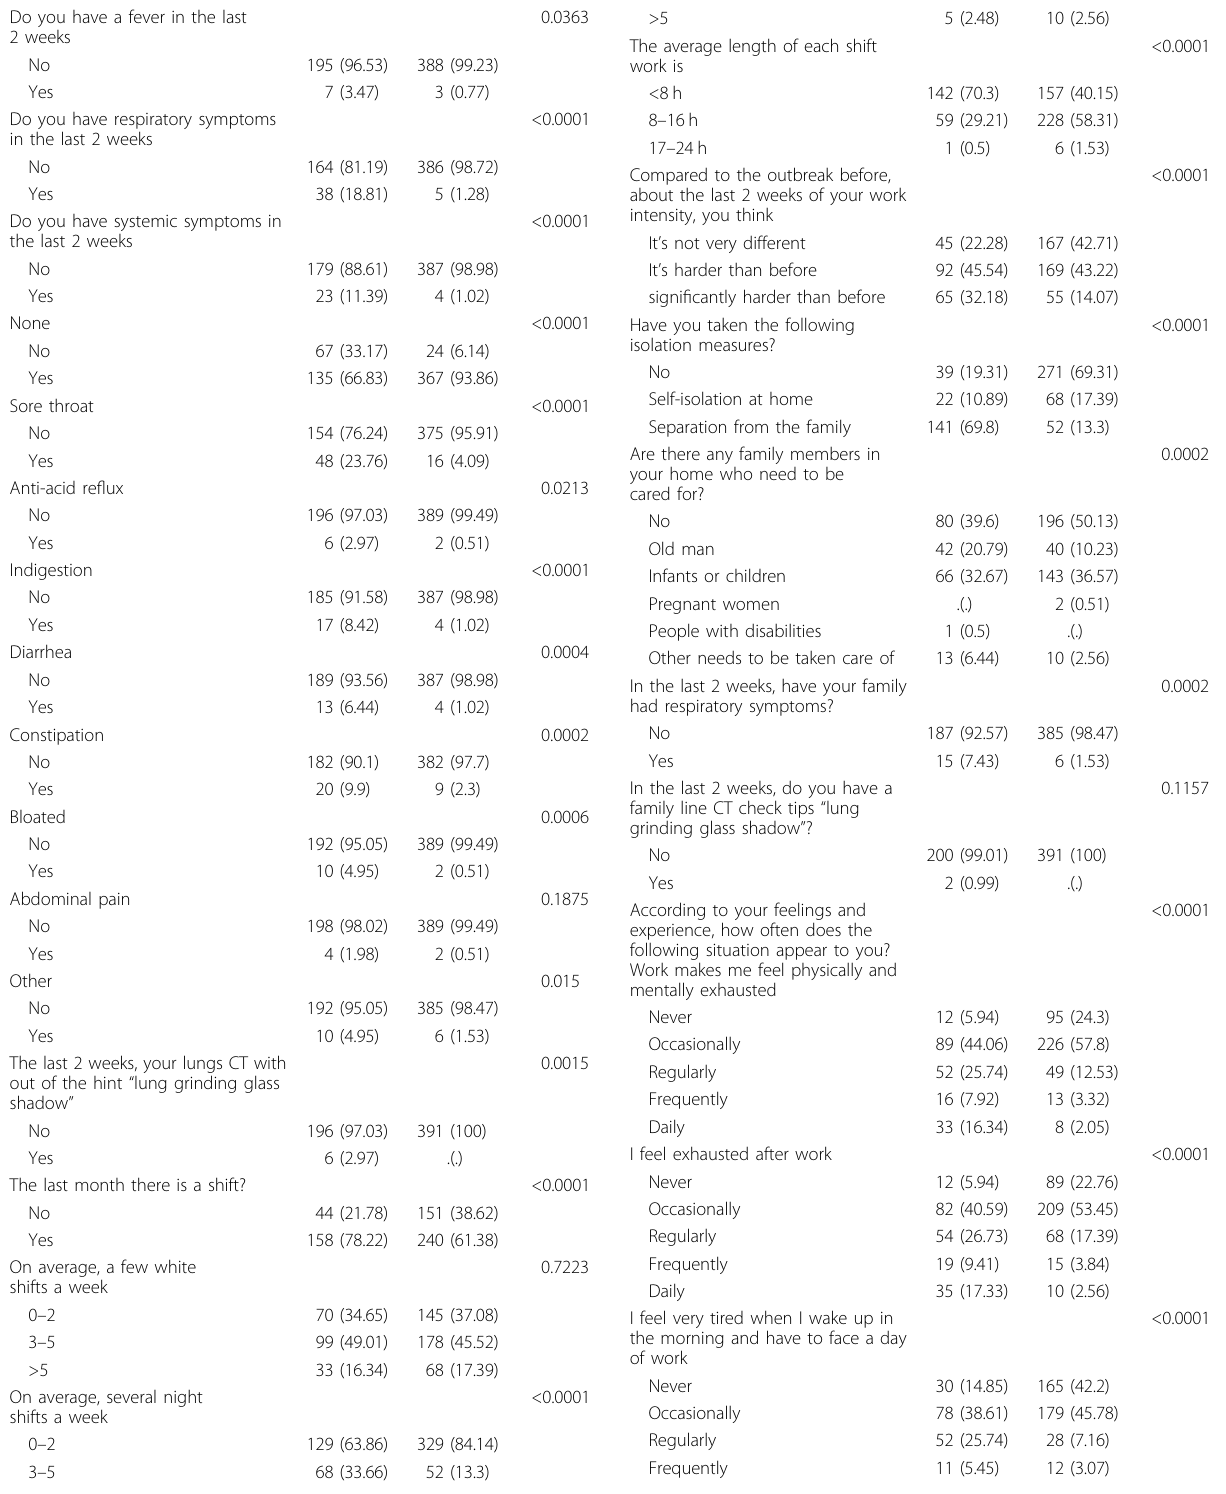
Table 2 Health condition of the